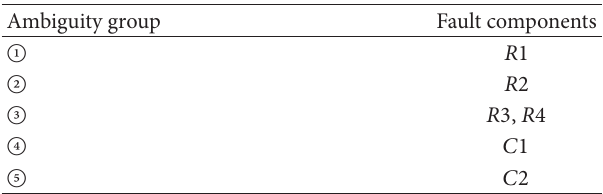
Table 2: Ambiguity groups of the Sallen-Key